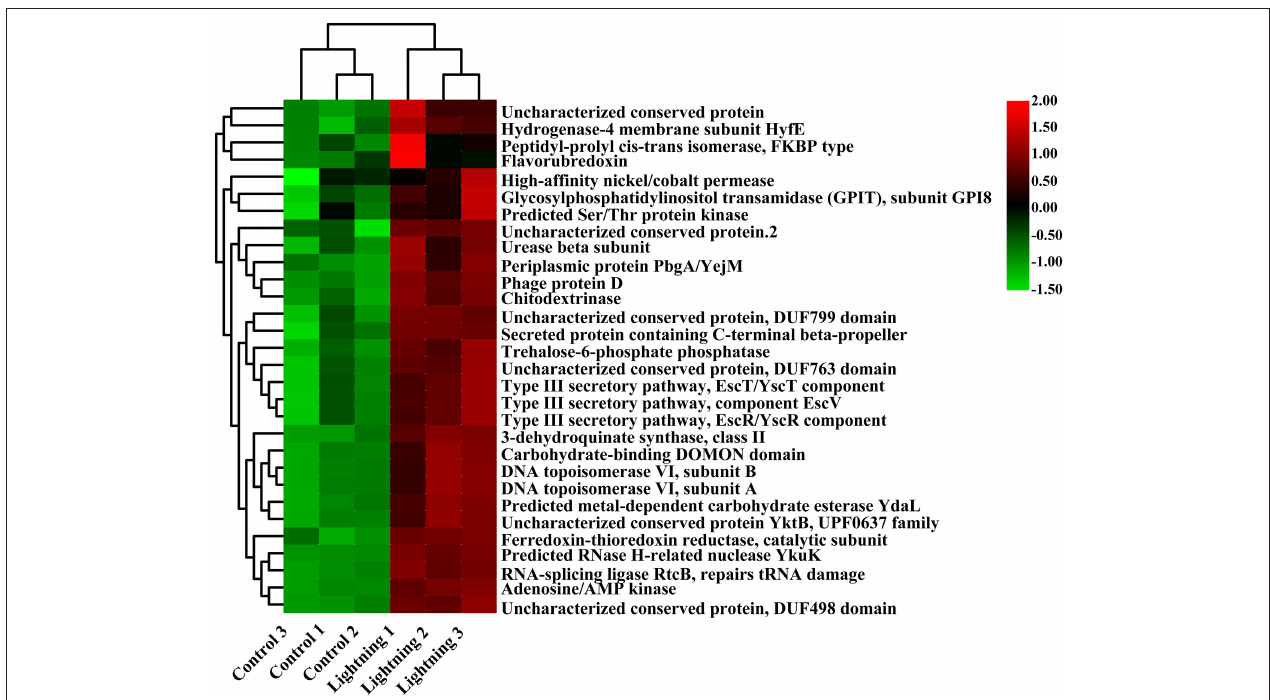
FIGURE 5 | Clusters of Orthologous Groups (COG) functions significantly enriched between different samples ( P < 0.05). The color block in the heat map from green to red indicates that the abundance of the sample increases gradually. Lighting represents a sample 10m from the lightning rod; Control indicates that the distance between the sample and the lightning rod is >